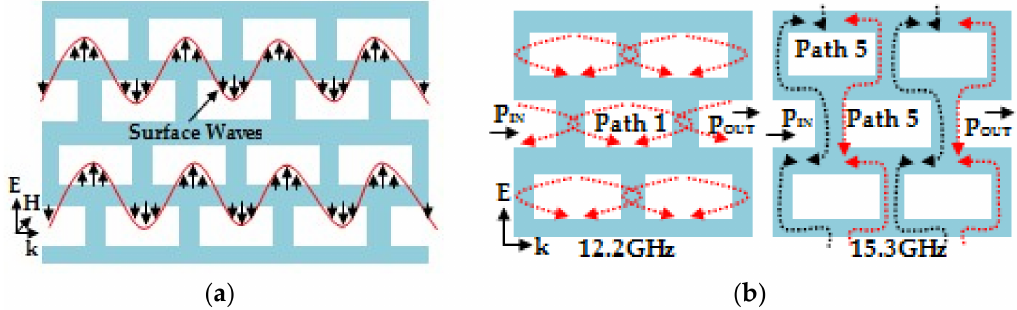
Figure 12. ( a ) Surface waveguide made of metallic frames. ( b ) Coupling of current through Three-Dimensional FSS (3D FSS) structure at transmission poles